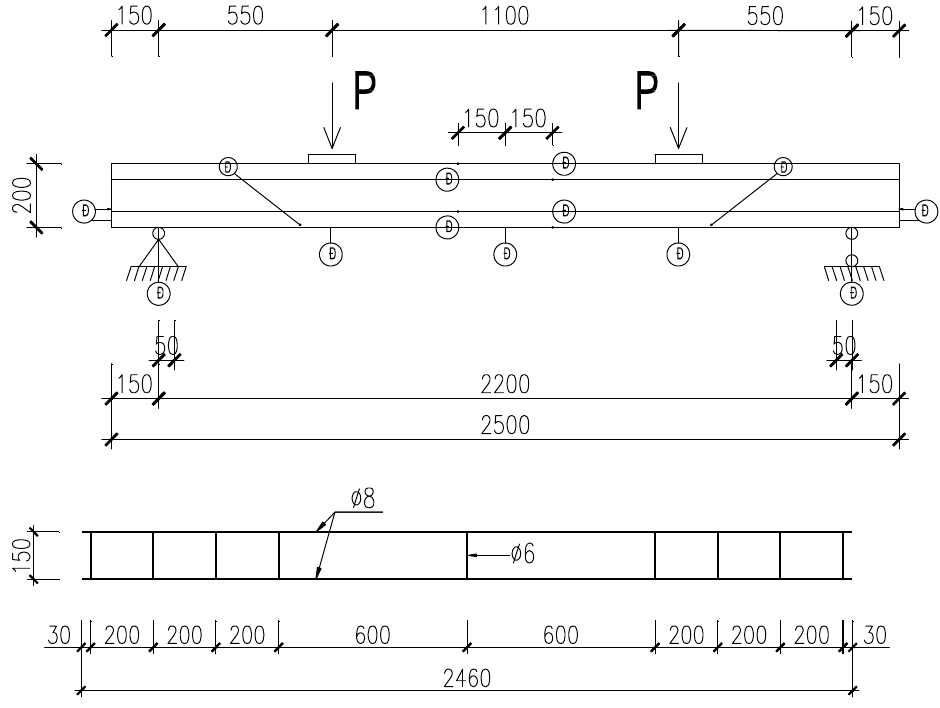
Figure 7. The schema of the tested beam in bending.